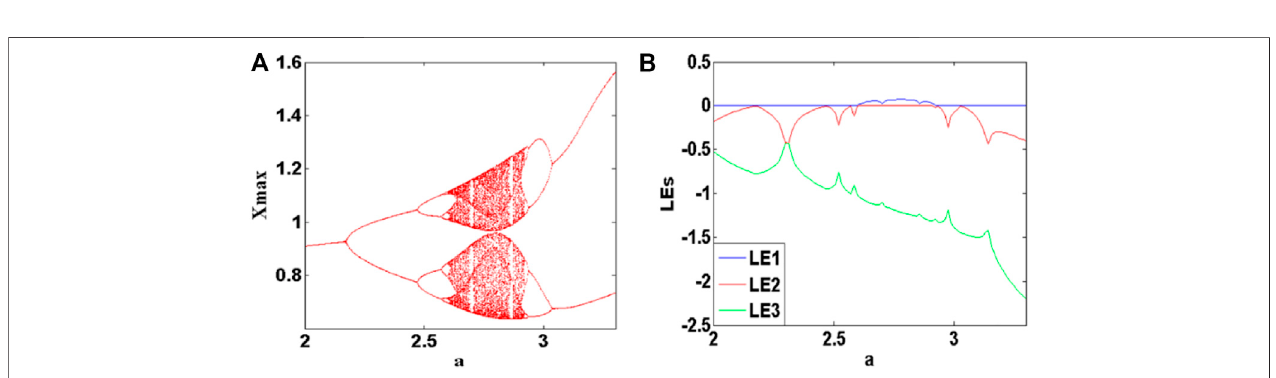
FIGURE 8 | Bifurcation and Lyapunov exponents of system (10) with b (cid:1) 5.5, c (cid:1) 1.7, d (cid:1) 2.5 and initial condition (0, 0, 0) when parameter a varies in [2, 3.3]. (A) bifurcation, (B) Lyapunov exponents.